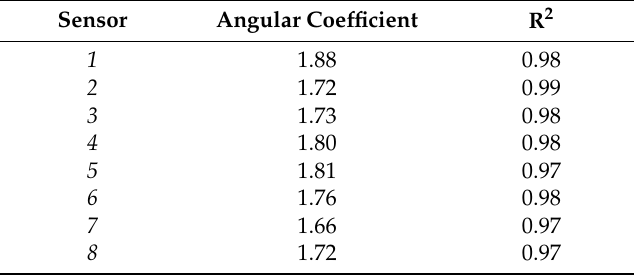
Table 3. Parameters of the linear regressions performed on the electrical conductivity (EC) sensors used in the experiment and evaluated at different EC levels, from 4 mS/cm up to 12 mS/cm, by incremental steps of 2 mS/cm.